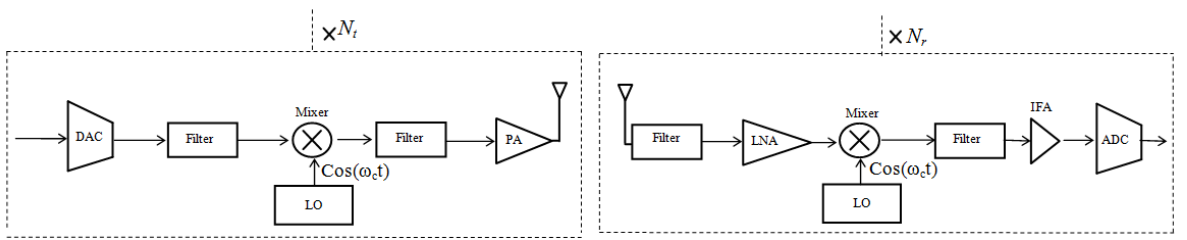
Figure 5. Transmitter and receiver architecture for WOFDM (analog).